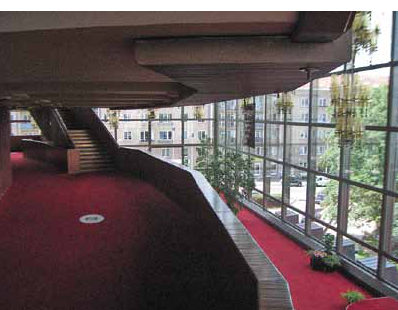
Fig. 12. Civic registry office (Wedding Palace). Interior view.